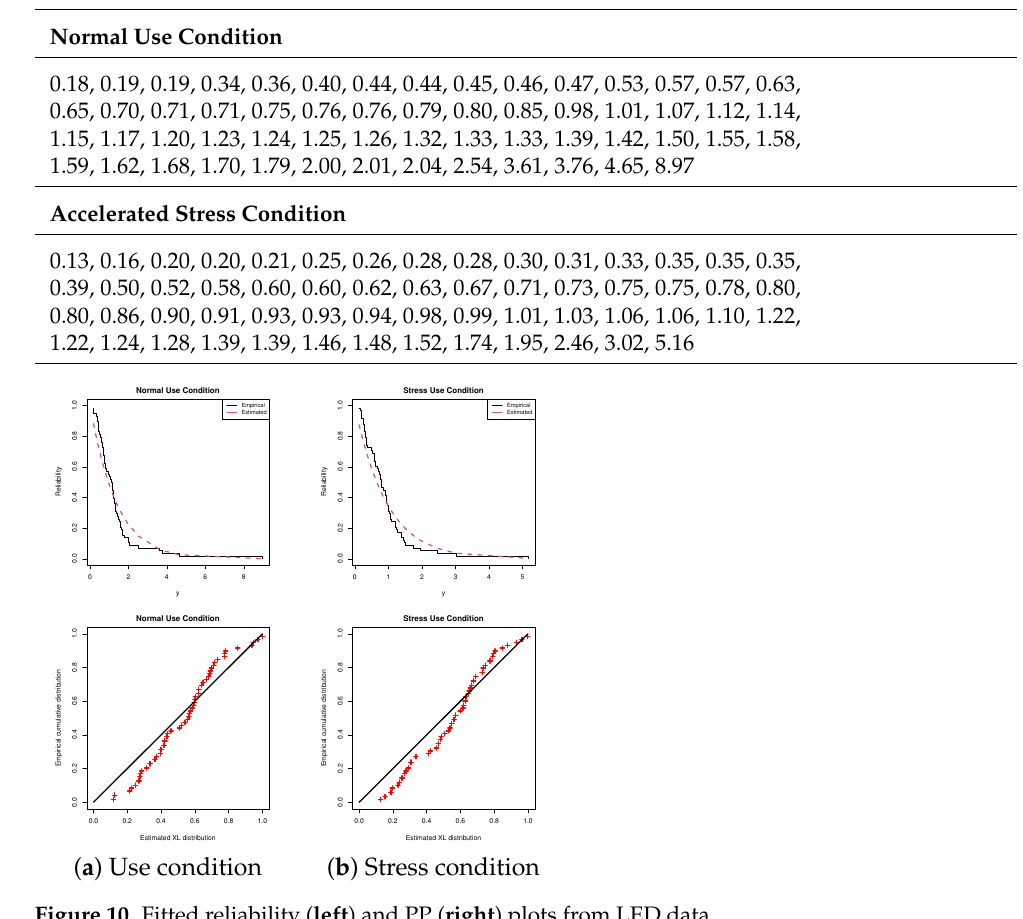
Table 7. Failure times of 58 LED products.